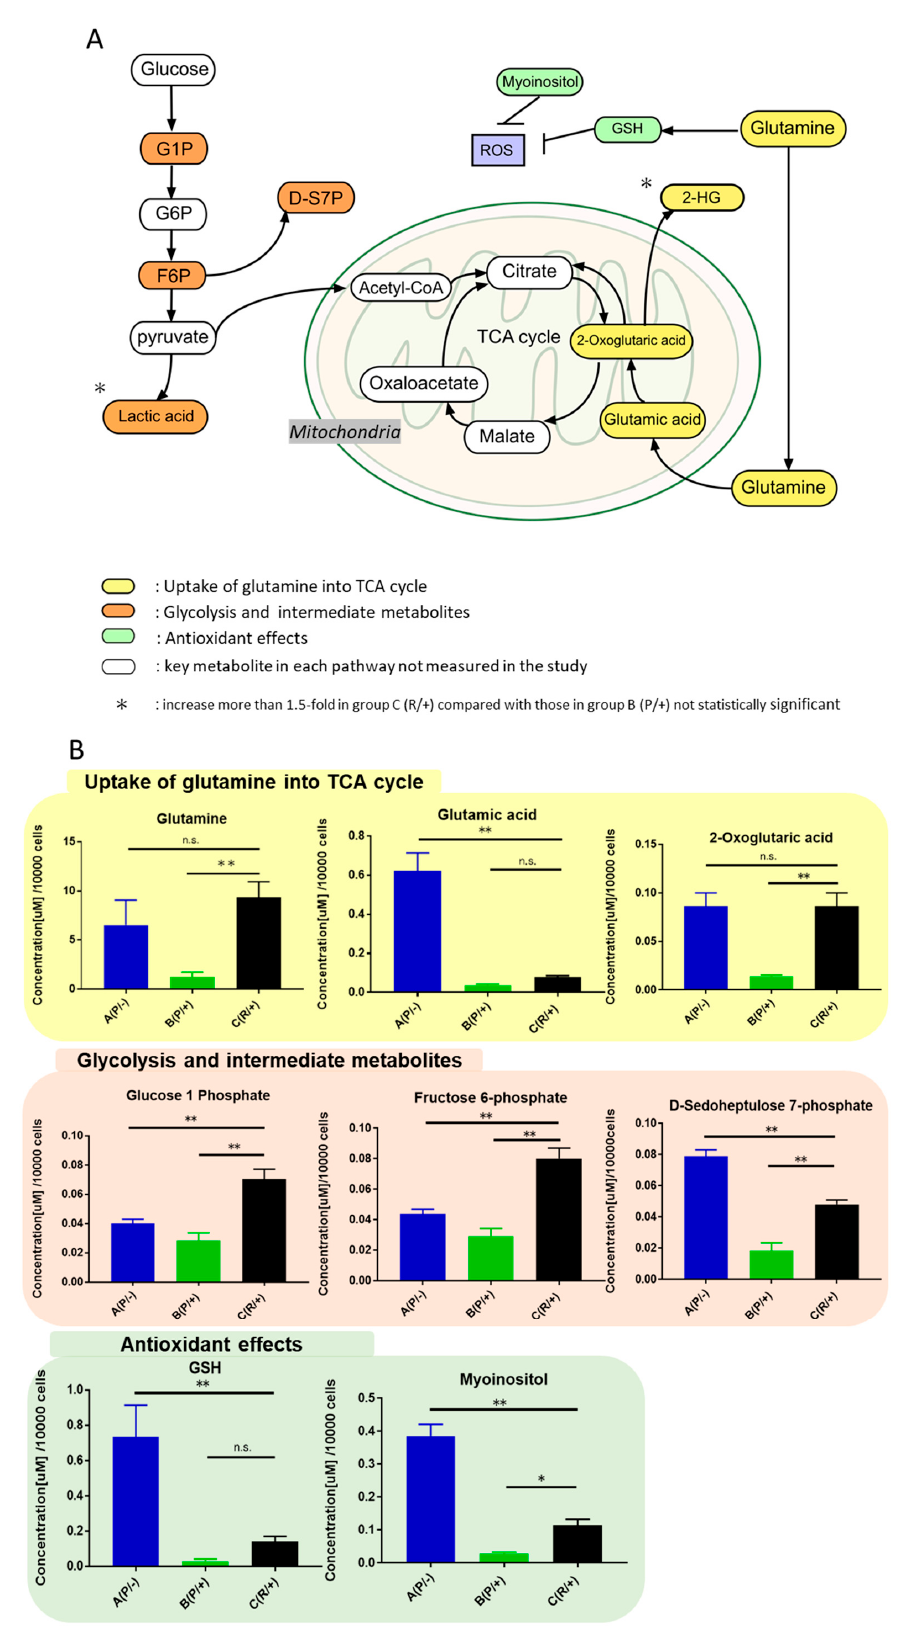
Figure 4. Metabolites increased in sunitinib-resistant cells and their metabolomic pathways. ( A ) Eleven metabolites were significantly increased in group C (R/+) compared with group B (P/+) ( p < 0.05 for all). Among these increased